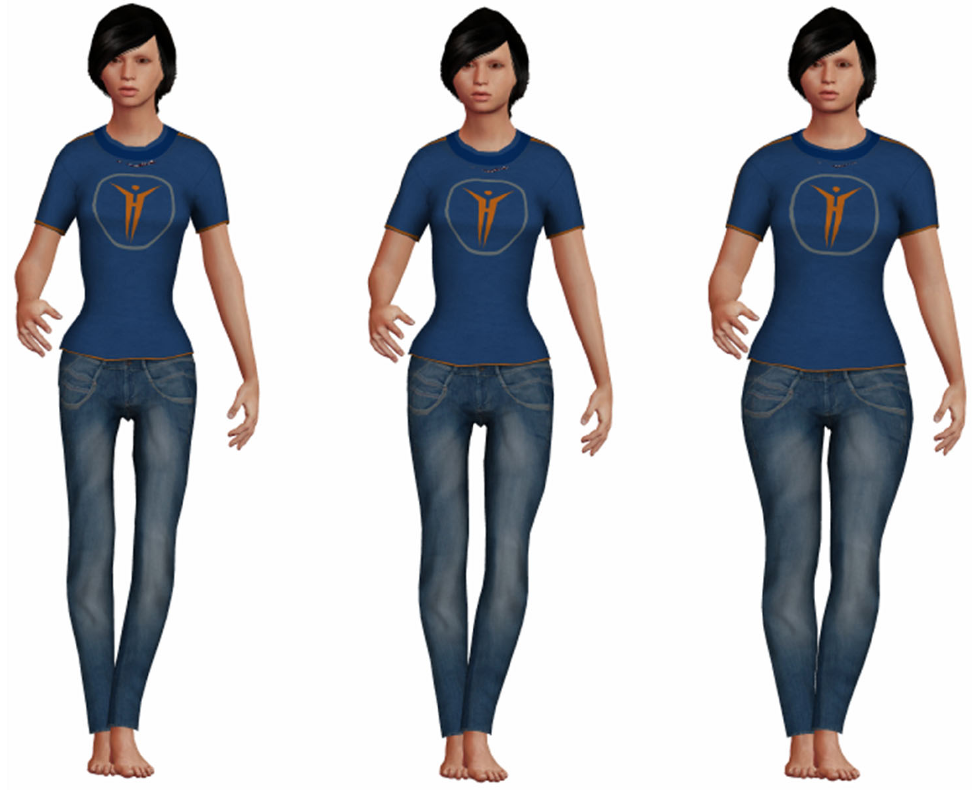
Figure 4. Example of avatar of progressively increasing BMI in the proposed VR application.